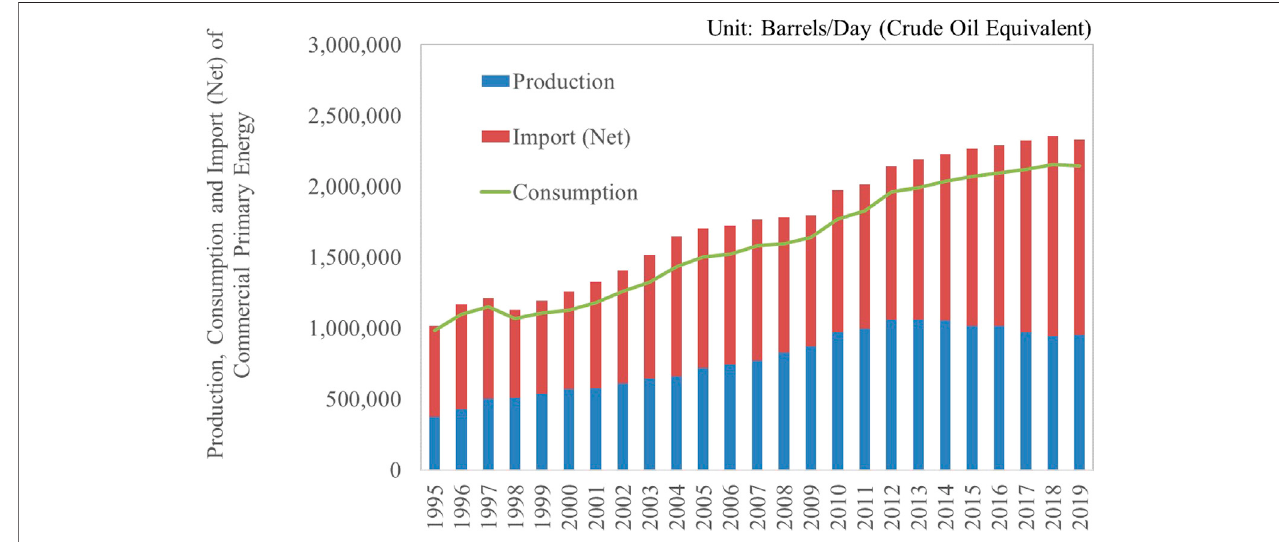
FIGURE 1 | Production, consumption, and import (net) of commercial primary energy (EPPO, 2020b).